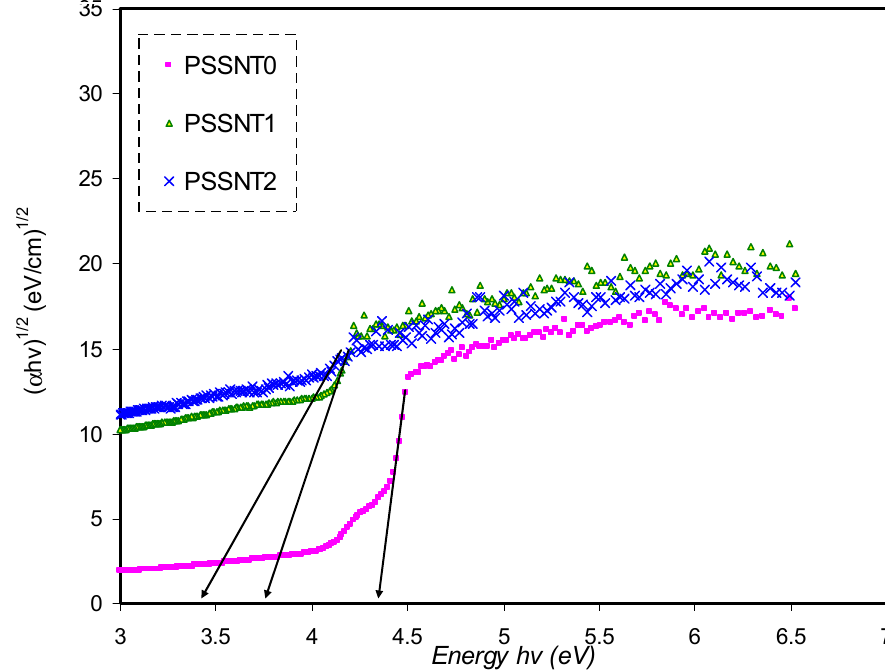
Figure 12. Plot of ( α h υ ) 1/2 versus photon energy for pure PS (PSSNT0), PSSNT1, and PSSNT2 NC films.